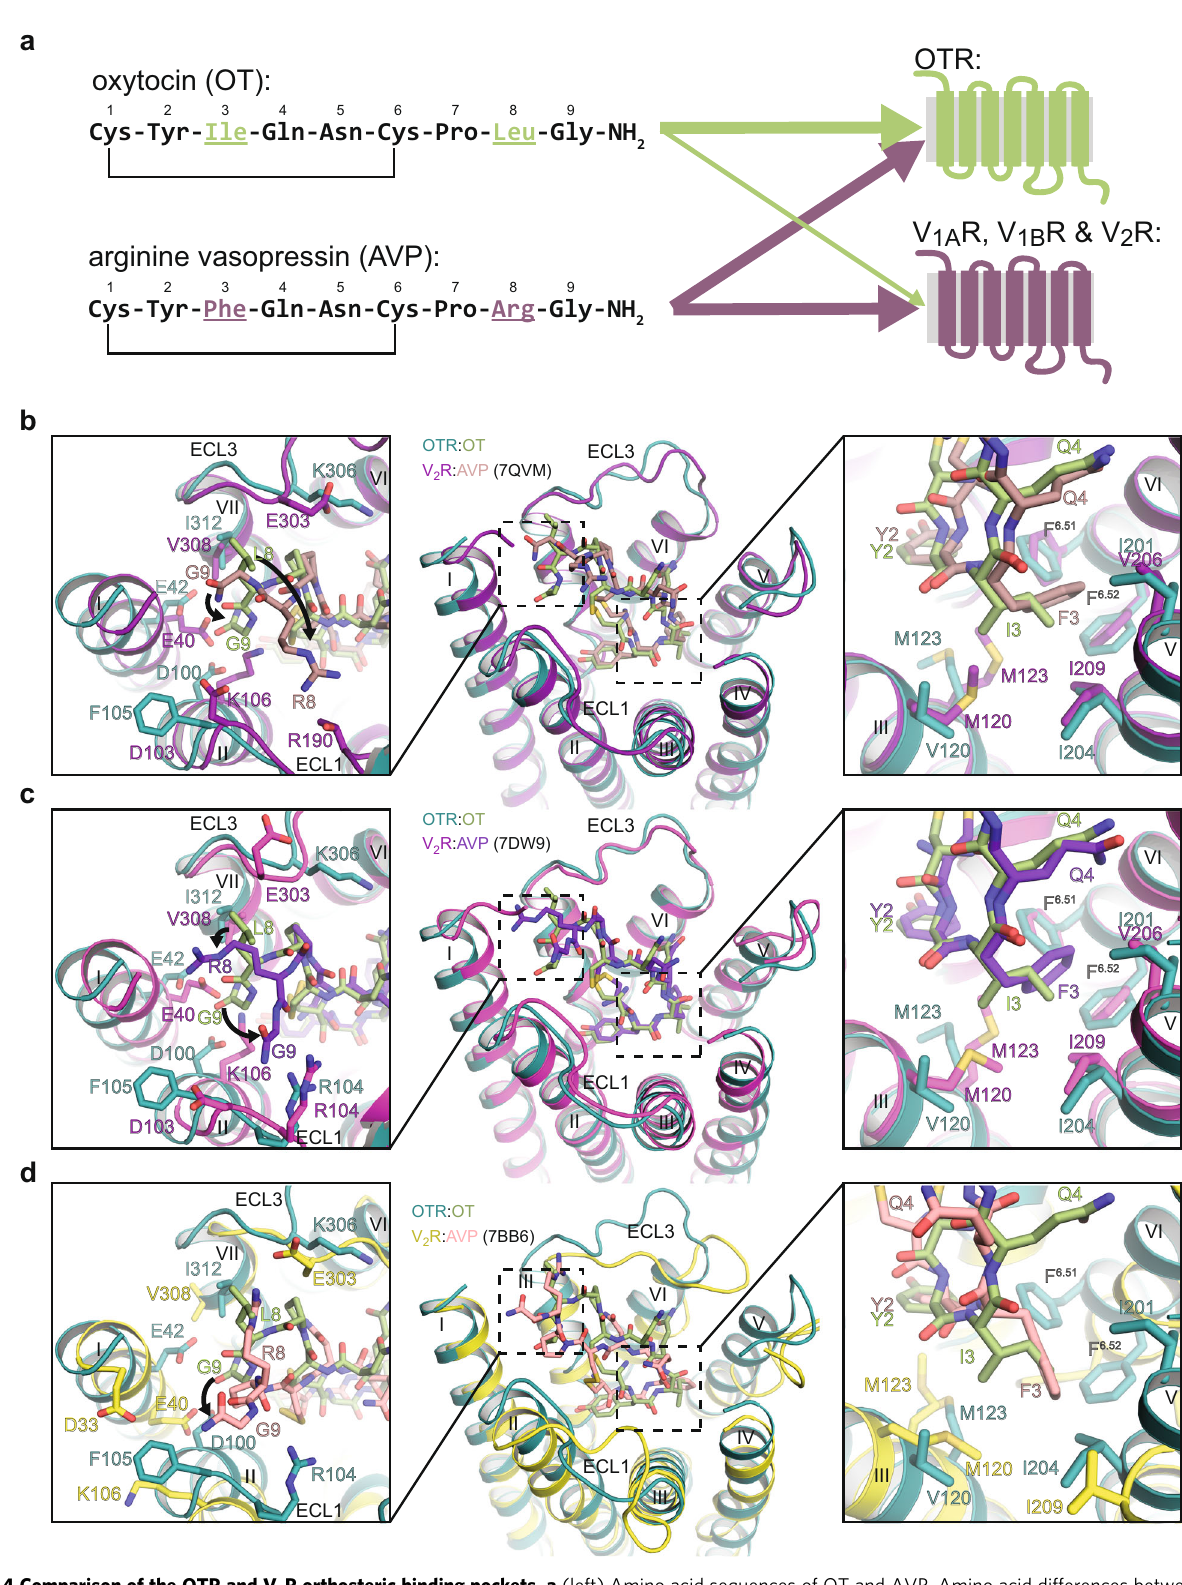
Fig. 4 Comparison of the OTR and V 2 R orthosteric binding pockets. a (left) Amino acid sequences of OT and AVP. Amino acid differences between the closely related hormones are highlighted. (right) Simpli fi ed speci fi city pro fi le of OT and AVP for oxytocin and vasopressin receptors. Line thickness indicates af fi nity towards indicated receptors. b – d Structural superposition of OTR:OT with V 2 R:AVP structures ( b PDB ID: 7QVM; c PDB ID: 7DW9; d PDB ID: 7BB6), illustrating the signi fi cant differences between AVP positions 3 and 8 in the two reported V 2 R:AVP structures. Arrows indicate conformational changes in non-conserved positions of AVP and OTR. (left) Close-up on sub-pocket binding AVP/OTR position 8. (middle) Overview of binding pockets. (right) Close-up on sub-pocket binding AVP/OTR position